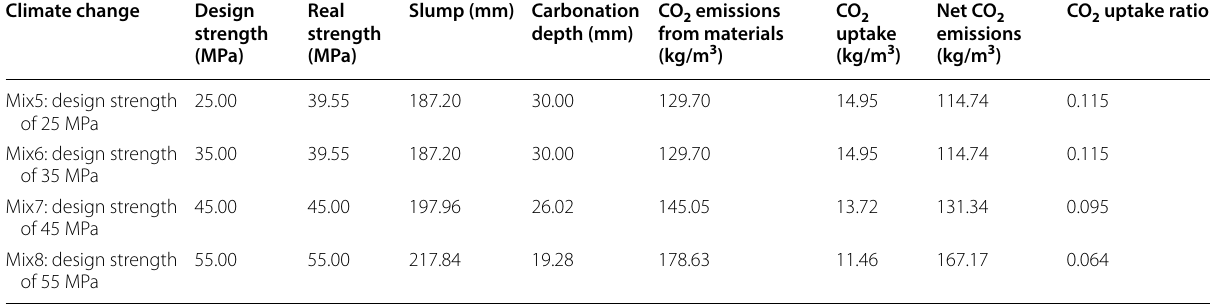
Table 8 Performance of concrete under a climate change scenario. Climate change